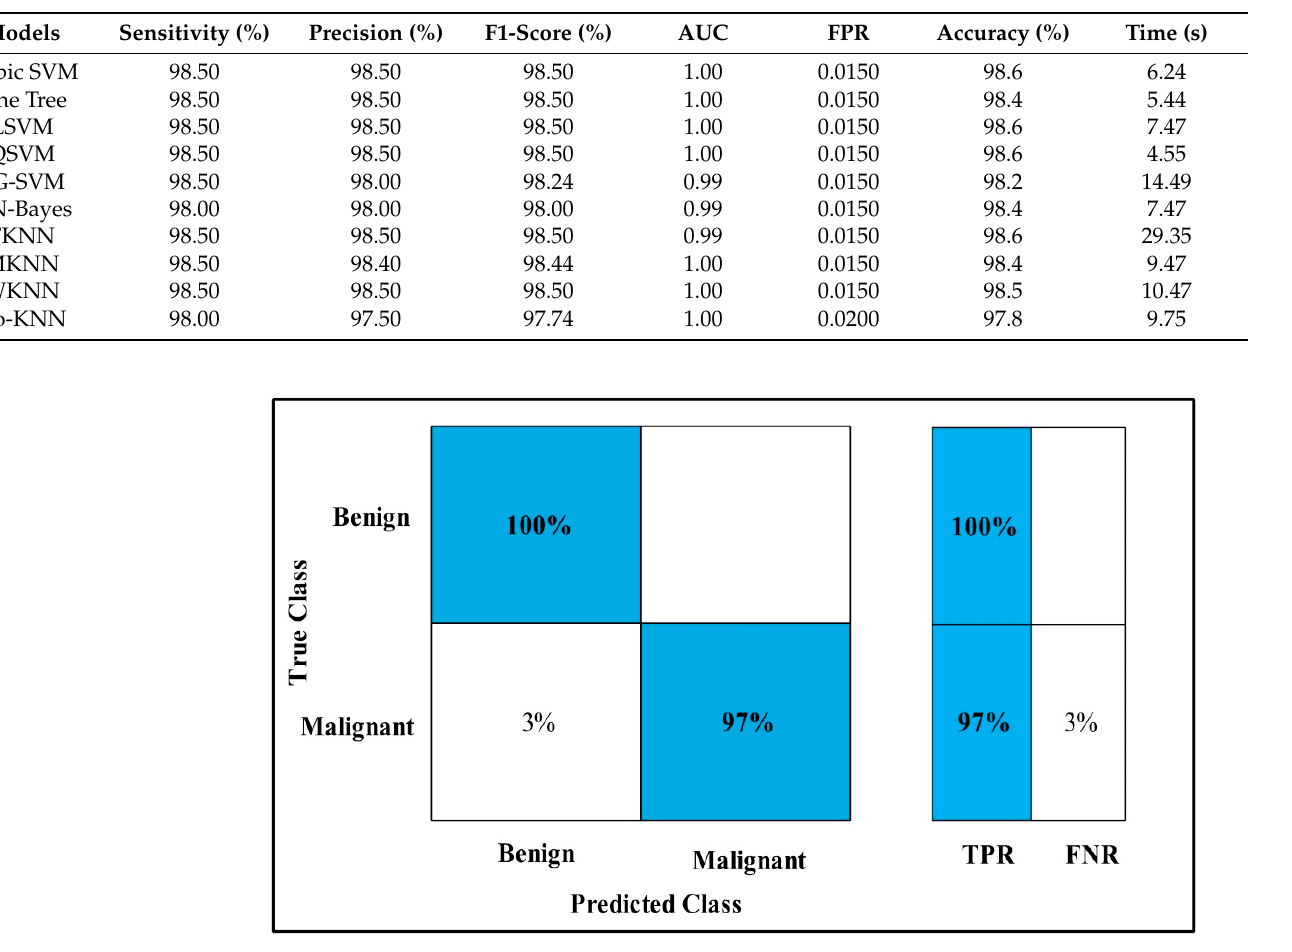
Table 17. Classification results using MEWOA Fine-tuned Nasnet deep features for INbreast.